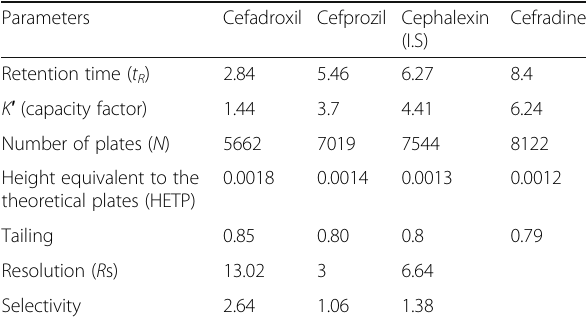
Table 2 System suitability parameters of the proposed HPLC-UV method